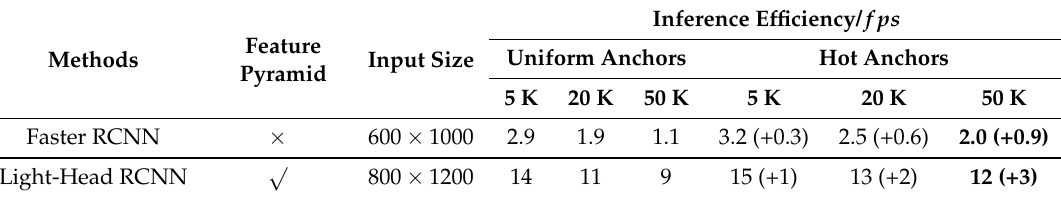
Table 2. The Inference Efficiency in Faster RCNN and Light Head RCNN. 1 K equals to